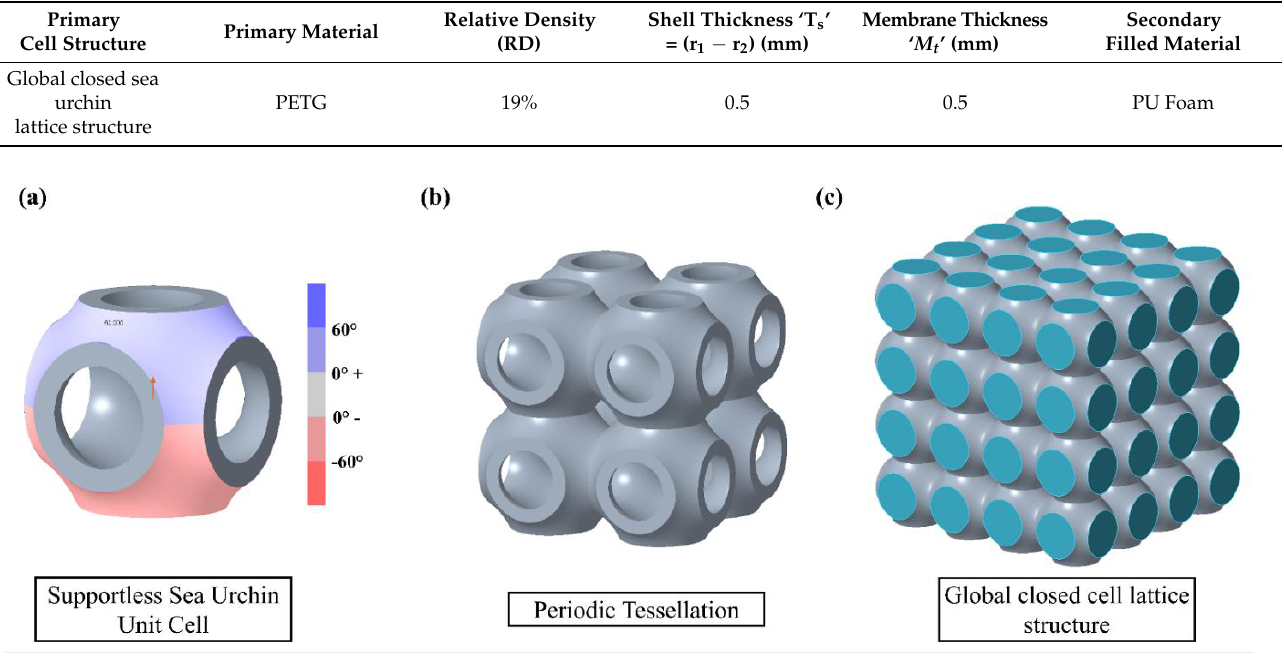
Table 1. Design parameters for lattice structures.